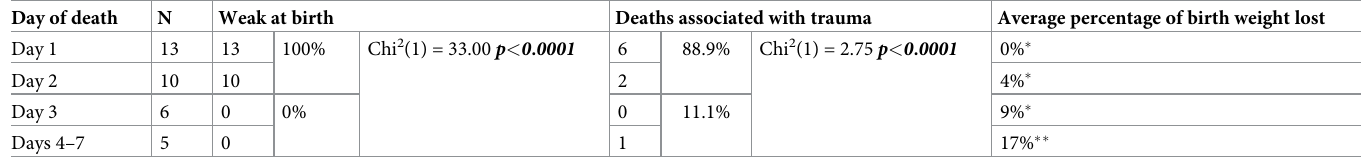
Table 5. Neonatal deaths within first week of